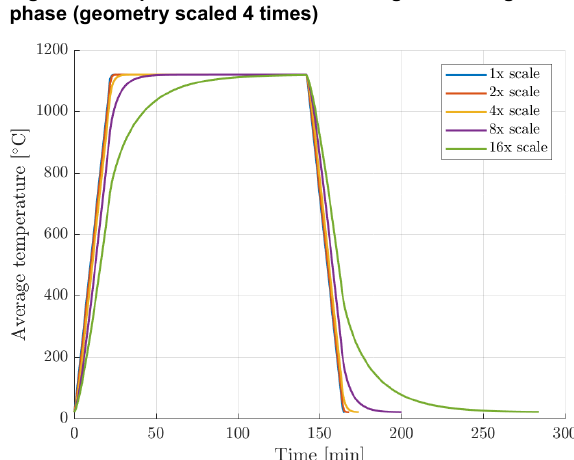
Figure 6. Average sample temperature during